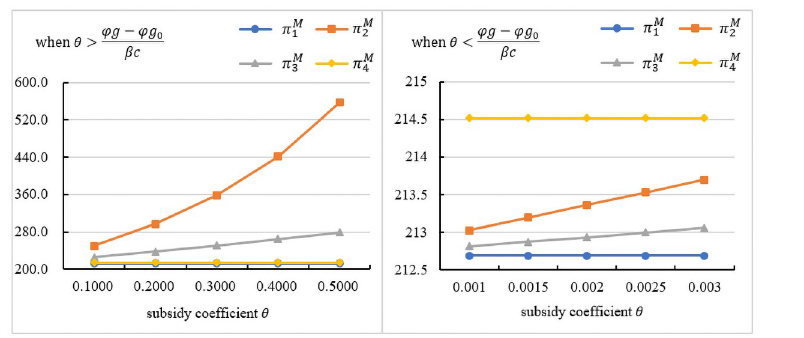
Fig 4. The influence of the subsidy coefficient on the manufacturer’s profit.